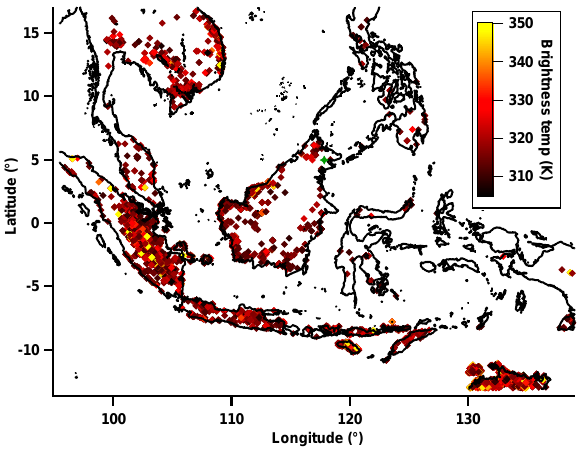
Fig. 9. MODIS hotspot/active fires coloured by temperature of event during OP3-III. Site marked with green star.